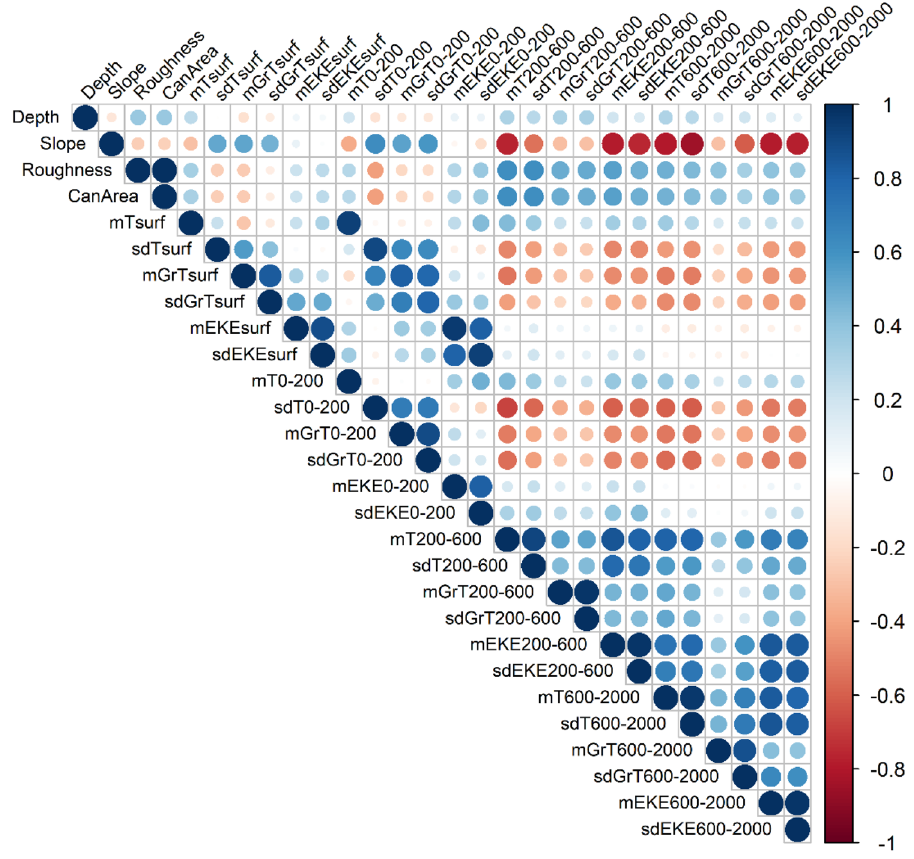
Figure 6. Correlation matrix of environmental variables. This matrix was calculated using the Pearson coefficient; the larger and darker the circle, the higher the correlation between the two environmental variables; variables are considered correlated for values below − 0.5 and above 0.5. CanArea: surface of canyons; T: temperature, GrT: gradients of temperature; EKE: eddy kinetic energy; m: mean; sd: standard deviation;